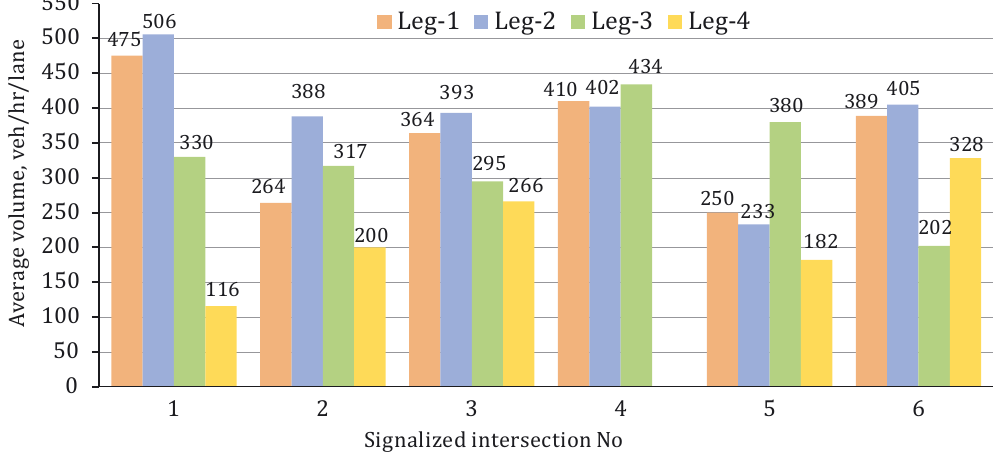
Signalized intersection Figure 4. Measured average lane volumes for each examined intersection leg